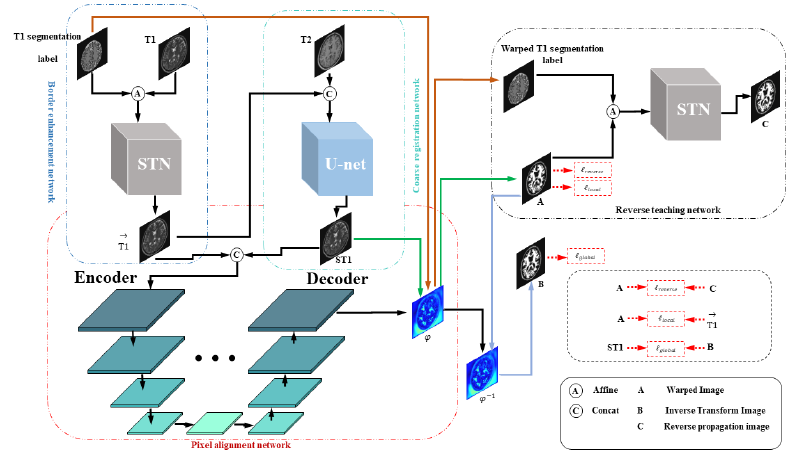
Figure 1. Overall architecture of our reverse-net.